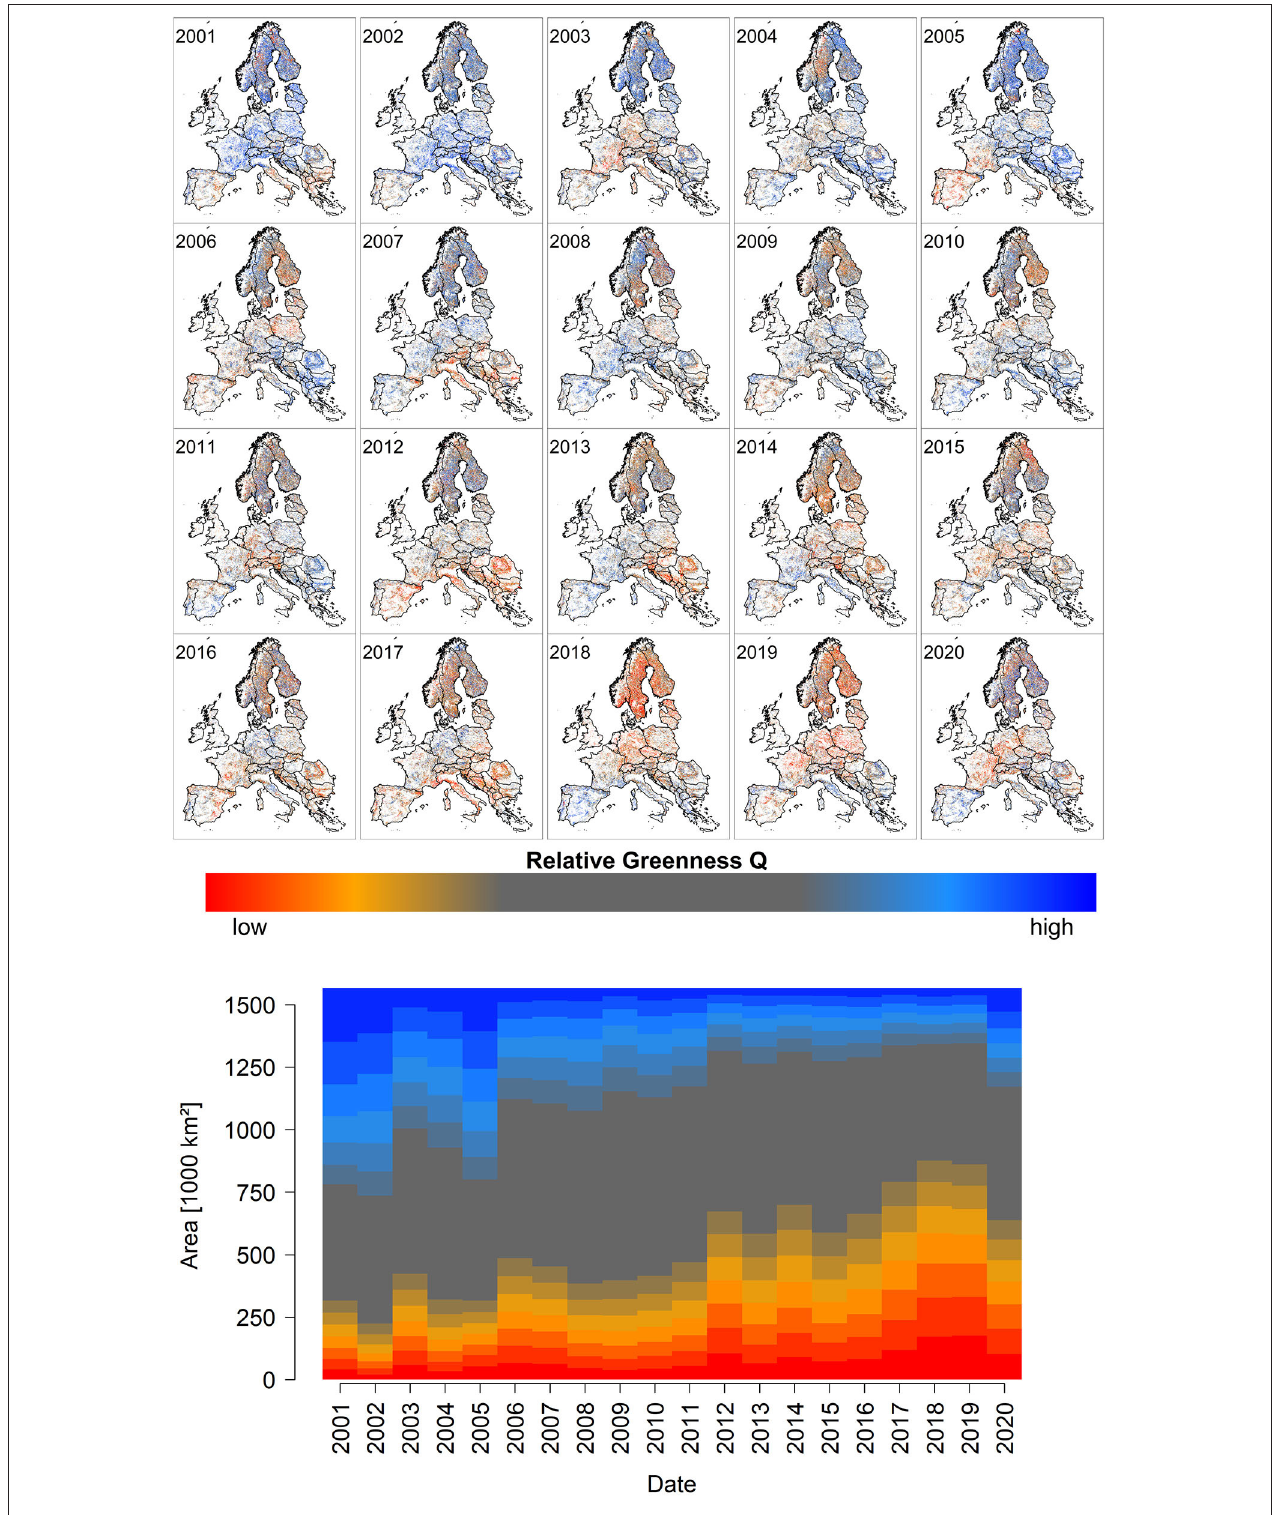
FIGURE 1 | The upper small panels depict the spatiotemporal development of peak season quantiles Q over the observational period from 2001 to 2020 (for an animated version with higher resolution please see Supplementary Video 1 ). The lower stacked barplot depicts the spatial share of corresponding quantiles. The value of Q increases from dark red over orange, gray, to blue shades. Supplementary Figure 1 depicts similar information for PDM . A video depicting the spatio-temporal variation of PDM is shown in the Supplementary Video 2 ).